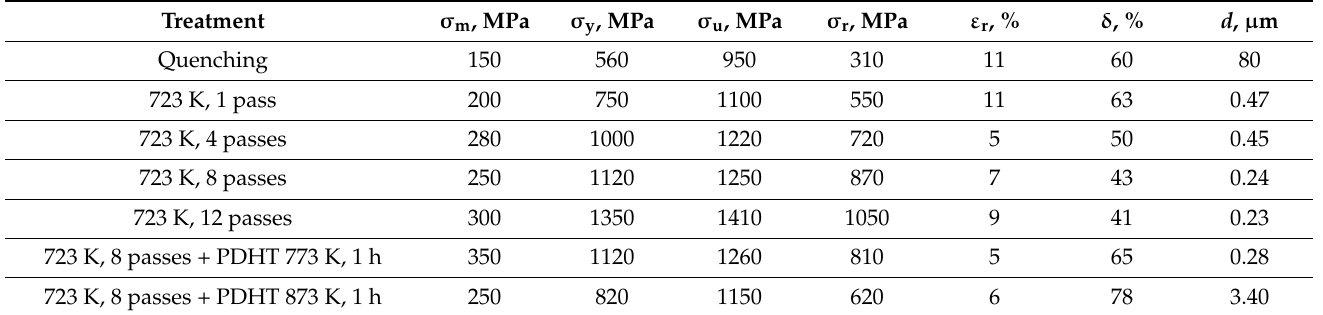
Table 3. Mechanical characteristics of Ti 49.8 Ni 50.2 alloy at RT before and after